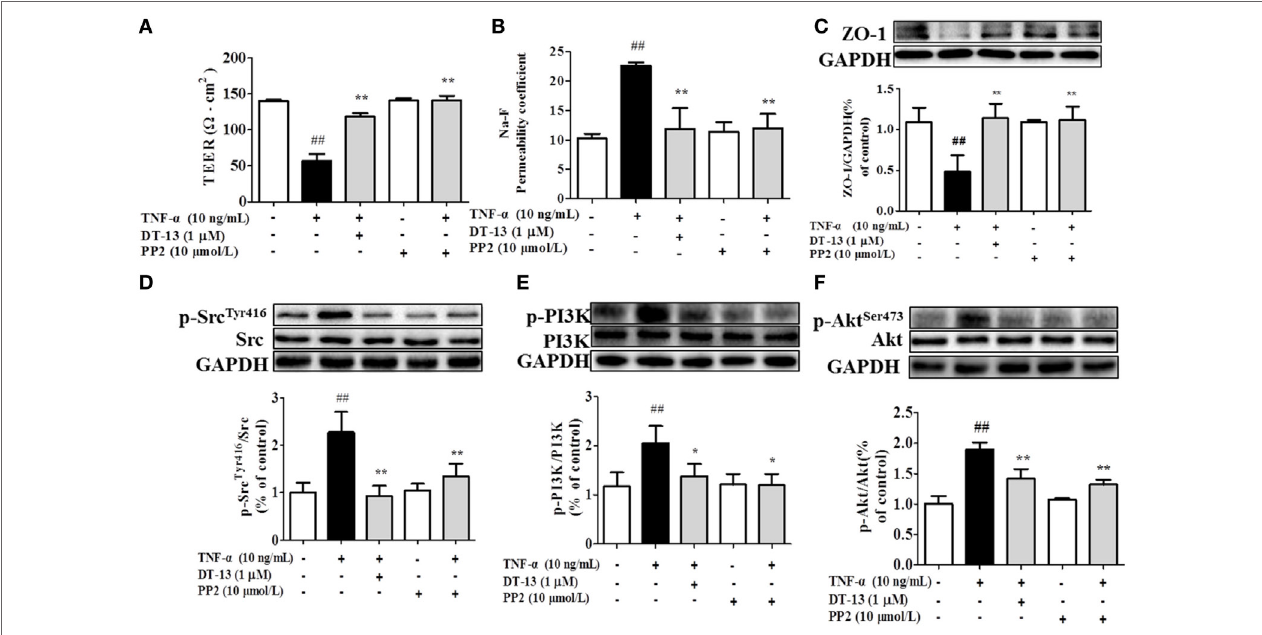
FigUre 4 | The Src pathway was related to DT-13 regulation of tight junction function induced by TNF- α . Permeability was assessed by transendothelial electrical resistance (TEER) and permeability of sodium fluorescein (Na-F) across the human umbilical vein endothelial cell (HUVEC) monolayer. (a) TEER was significantly elevated in HUVECs pretreated with 10 µM PP2. (B) Na-F permeability was significantly reduced in HUVECs pretreated with 10 µM PP2. Western blotting analysis for the effect of DT-13 on (c) ZO-1, (D) phosphorylation of Src, (e) PI3K, and (F) Akt in endothelial cells. The cells were pretreated with 10 µM PP2 for 1 h prior to addition of 1 µM DT-13 for 1 h and were then incubated with TNF- α for another 4 h for Western blot analysis. The data represent the mean ± SD from three experiments. ## P < 0.01 vs. the control group; * P < 0.05, ** P < 0.01 vs. the TNF- α